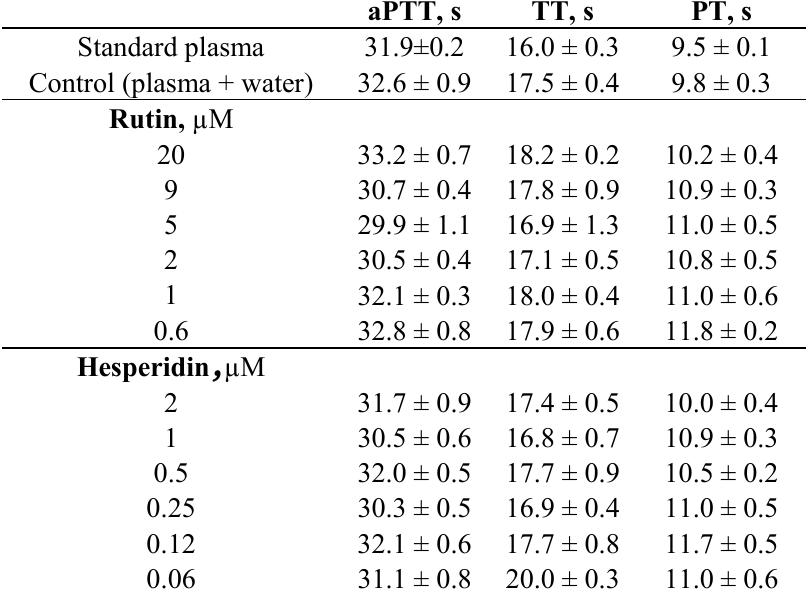
= 20 µM, c = 2 Rut Hesp